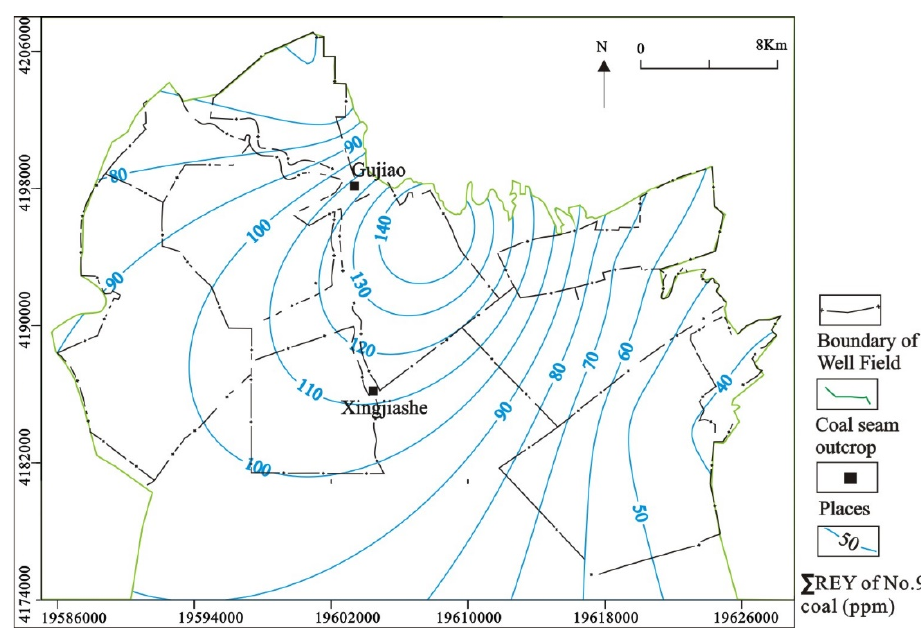
Figure 10. Total content of REY in No. 9 coal. Table 7. Rare earth element content of coal samples (µg/g).